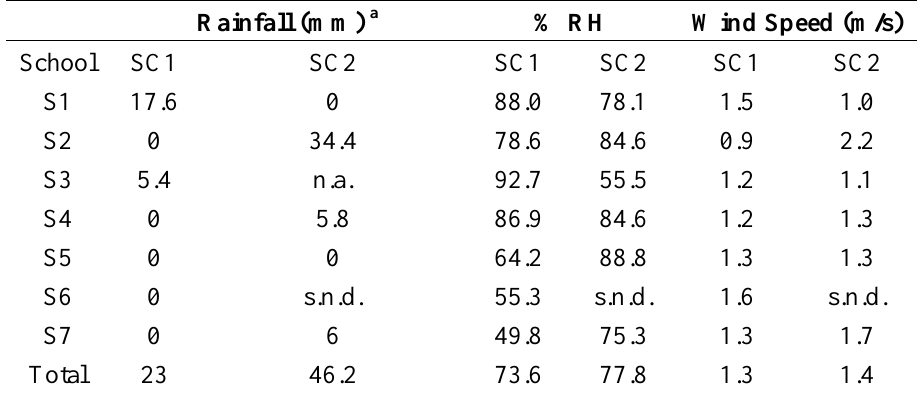
concentrations 2.5